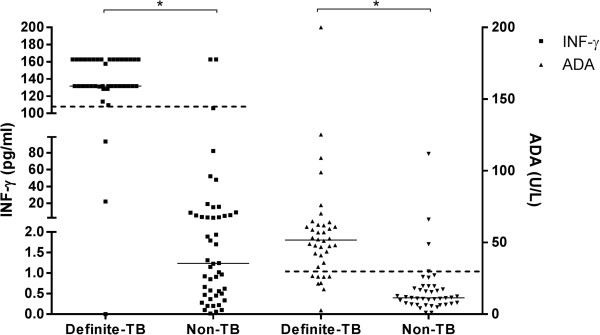
Scatter plot of interferon gamma (IFN-γ) and adenosine deaminase (ADA) using pleural fluid from patients with TB and non-TB pleural effusions. *: p < 0.0001 (Mann-Whitney). See Additional file 1: Table S6 in the online supplementary data for final diagnosis of non-TB patients with ADA and/or IFN-γ levels above cut points.